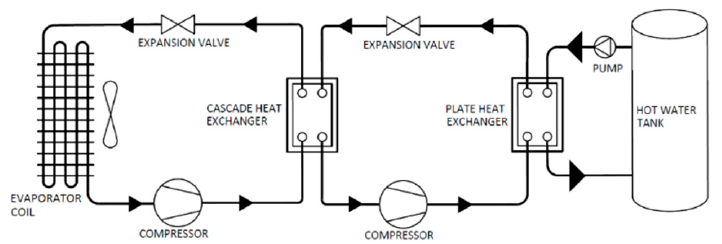
15 of 29 Table 4. Summary of studies of SAHP systems. References